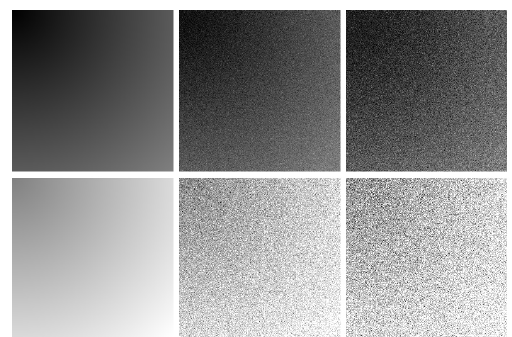
Fig. 1. Synthetic and the respective Rician noise-corrupted images: a pair of original images (first column), images re- spectively corrupted by noise of SNR =15 (second column), and by noise ratio of SNR =10 (third